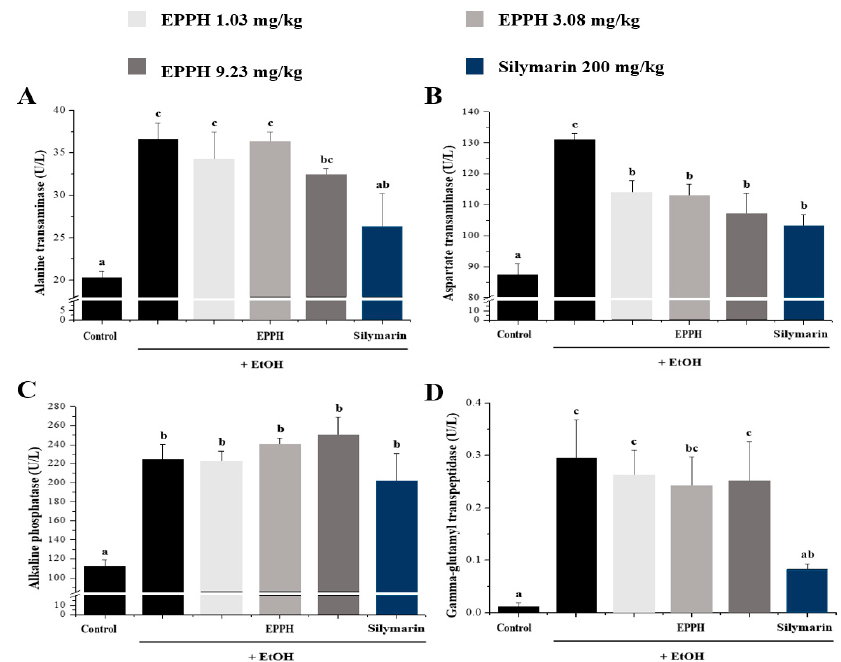
Figure 2. Antioxidant enzymes in blood serum were measured after sacrifice by conventional methods. ( A ) alanine transaminase (ALT), ( B ) aspartate transaminase (AST), ( C ) alkaline phosphatase (ALP), and ( D ) gamma-glutamyl transpeptidase (GGT). Silymarin is a positive control. The data are expressed as the mean ± SD ( n = 10), and different letters indicate (c > b > a) a significant difference at p < 0.05, as determined by Duncan’s multiple-range test.